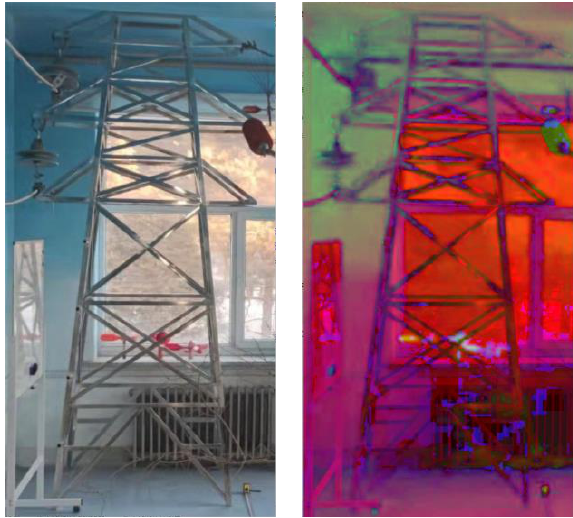
Figure 2. RGB images converted to HSV images.